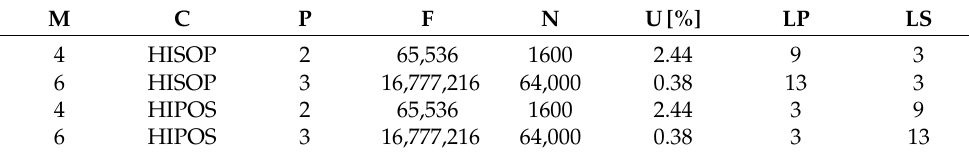
Table 6. Review of characteristics for different CHB-B2B converter hybrid configurations.